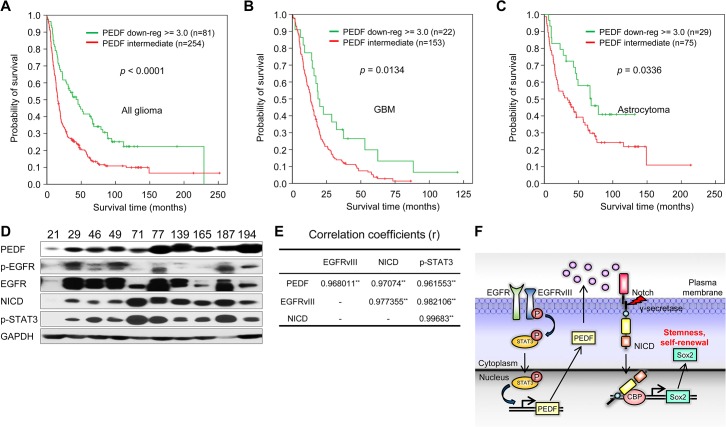
PEDF expression correlates with patient survival in human glioma.(A–C) Kaplan-Meier plot of survival curve for all glioma patients (A; p < 0.0001), GBM patients (B; p = 0.0134), and astrocytoma (C; p = 0.0336). These data are based on the log-rank test. Data were obtained from the Repository for Molecular Brain Neoplasia Data (REMBRANDT) program of the National Cancer Institute. (D) IB analysis of PEDF, p-EGFR, EGFR, NICD, and p-STAT3 using protein extracts from GBM patient tissues. GAPDH was used as a loading control. (E) Table represents correlation coefficients (r) of PEDF, EGFRvIII, NICD, and p-STAT3. ** p < 0.01. (F) A schematic model illustrates the signaling and function of PEDF. Image credit: Eunji Choi.